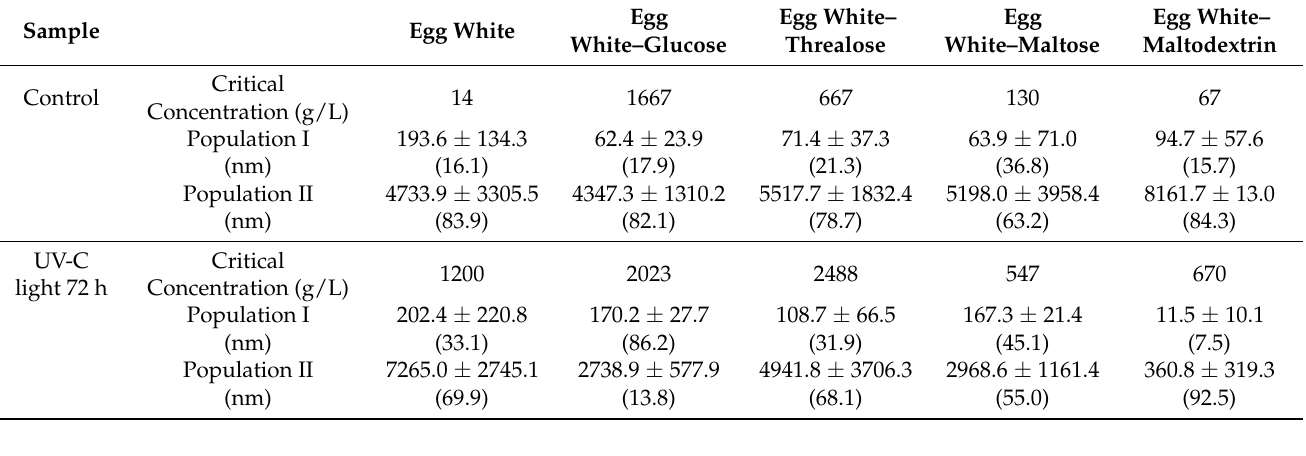
Table 3. Critical concentration and hydrodynamic radius ( ± population dispersion around the peak) of particles relevant to populations I and II in aqueous suspensions of egg white and egg white–sugar mixtures before and after exposure to UV-C light for 72 h. Population percentage in brackets.